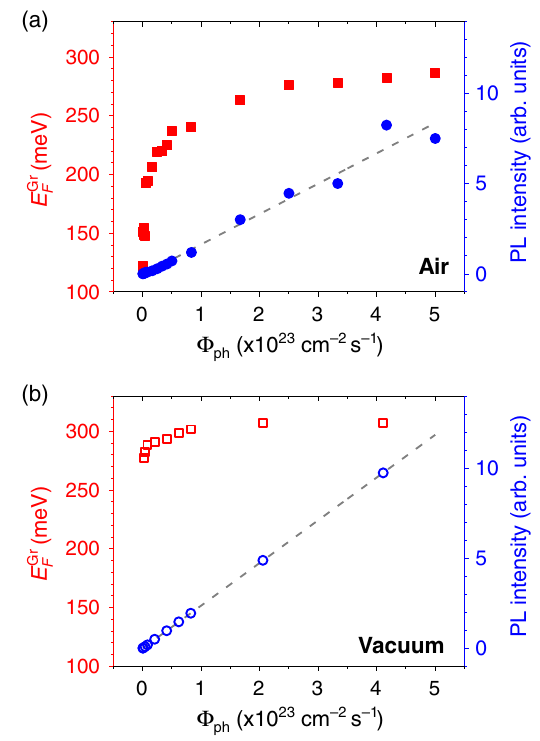
FIG. 6. Comparison between the dependence of the Fermi energy in graphene E Gr F (left axis, red) and the PL intensity of the (right axis, blue) on Φ , measured on A exciton in MoSe 2 I A ph PL sample S 2 (a) in ambient air and (b) in vacuum at a laser photon energy of 2.33 eV. The dashed lines are linear fits to the photoluminescence